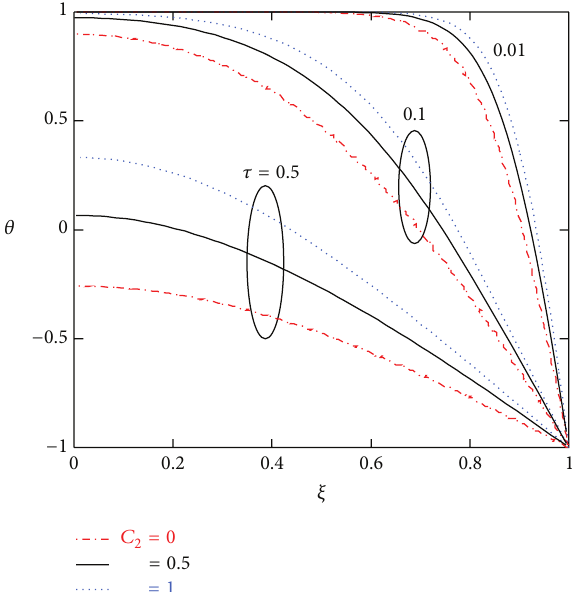
Figure 6: Transient temperature profiles in slab with different latent heats for 𝐶 2 = 0 , 𝐶 3 = 0.5 , 𝛼 = −10 , 𝛽 2 = 0 , 𝜃 0 = 0 , and (𝑀, 𝑁) = (40, 4) with 𝜉 -domain division into six subdomains (i.e., 𝐺 = 1/6